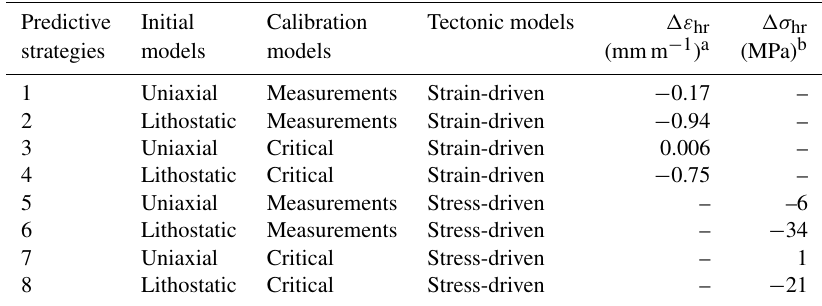
Table 1. The eight predictive strategies. Predictive strategy 1 is commonly used in literature.